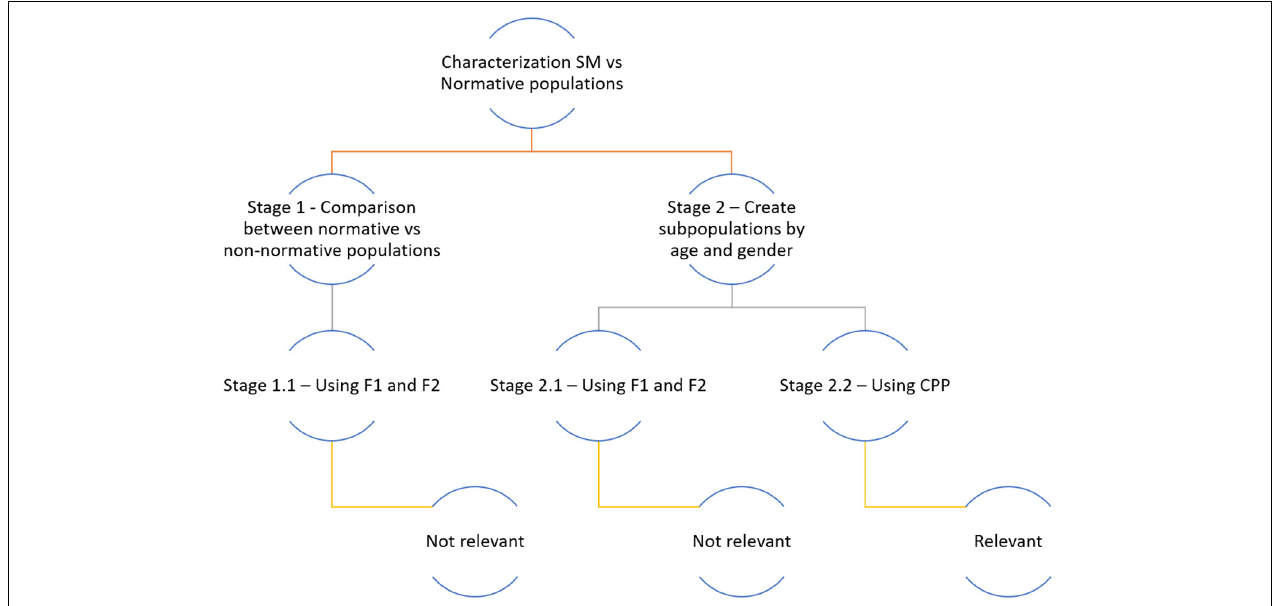
FIGURE 2 | Phases of the study and statistical treatment of the data.